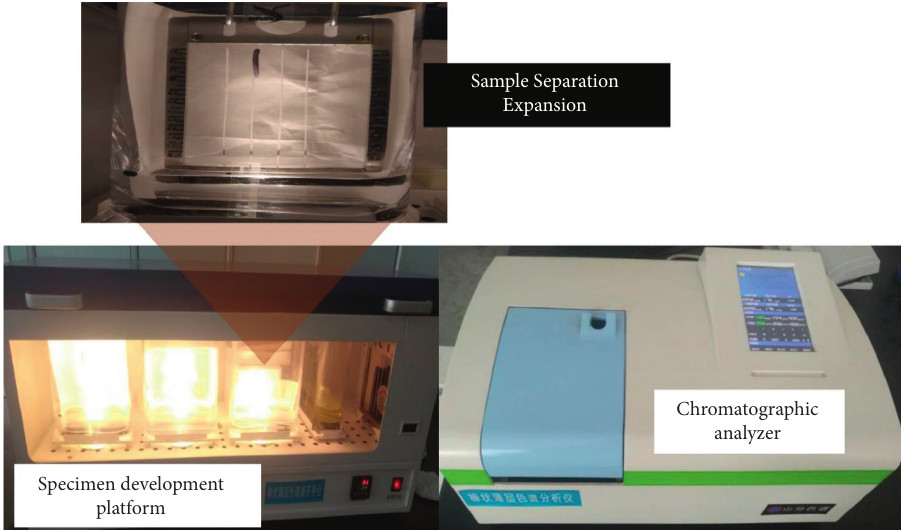
Figure 4: Setup for bar thin layer chromatography analyzer.